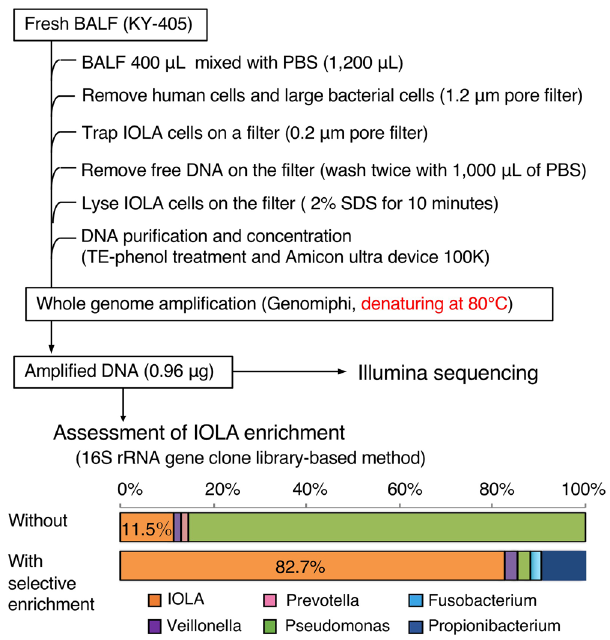
Fig. 1 Protocol for selective ampli fi cation of the IOLA genome. The processes of DNA extraction and selective ampli fi cation of IOLA genomic DNA are shown. The proportions of IOLA DNA in the DNA preparations obtained with or without selective ampli fi cation were estimated by the 16S rRNA clone library-based method (61 and 75 clones were analyzed,